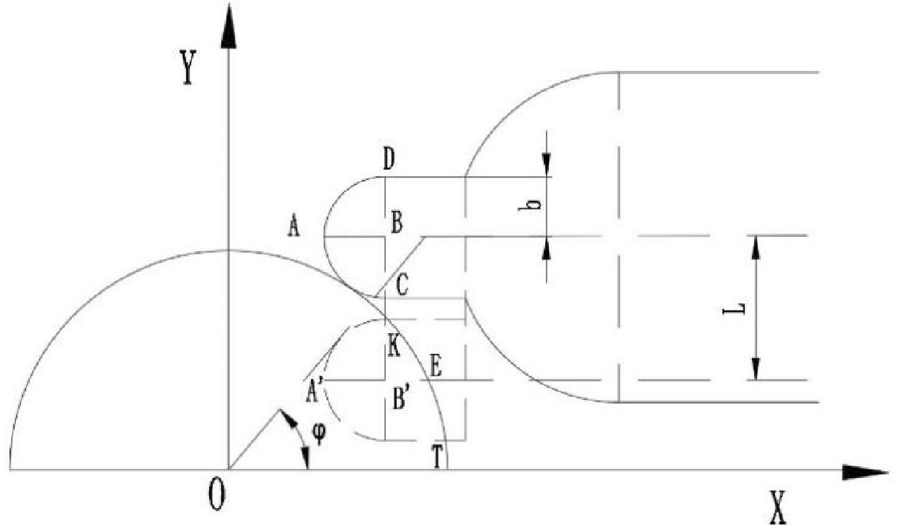
Figure 9. U-shaped buffer tank model establishment coordinate